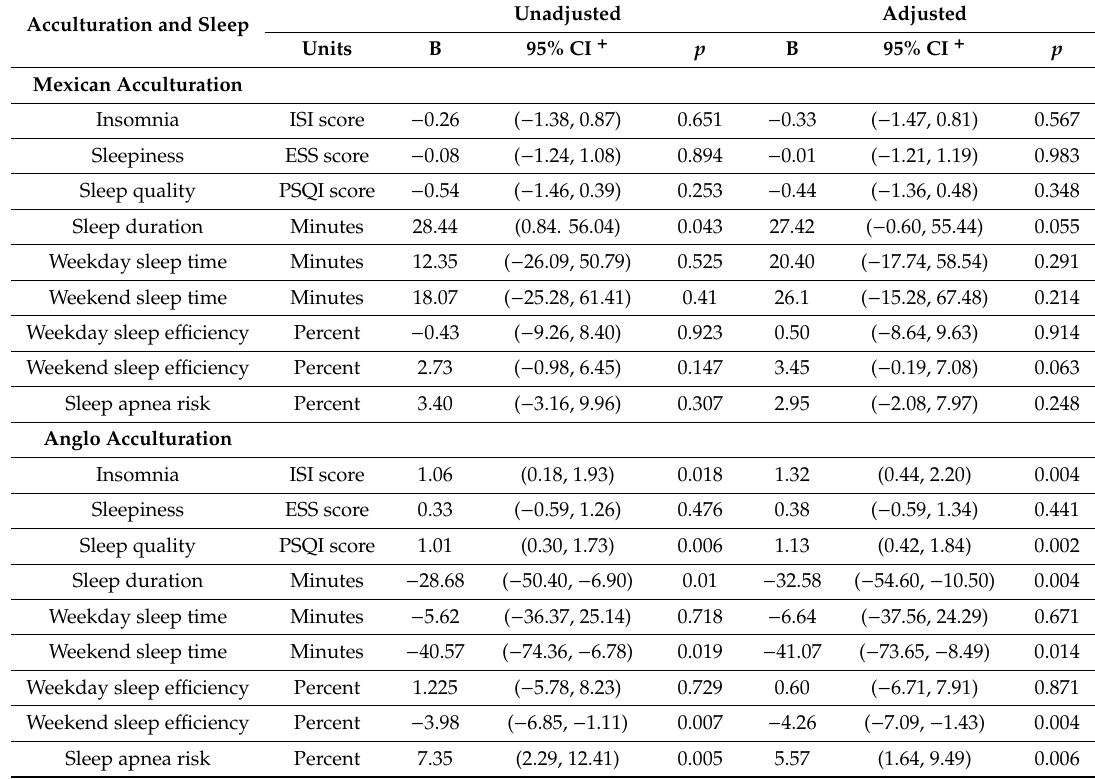
Table 2. Association between acculturation and sleep characteristics among individuals of Mexican descent at the United States (US)–Mexico border.